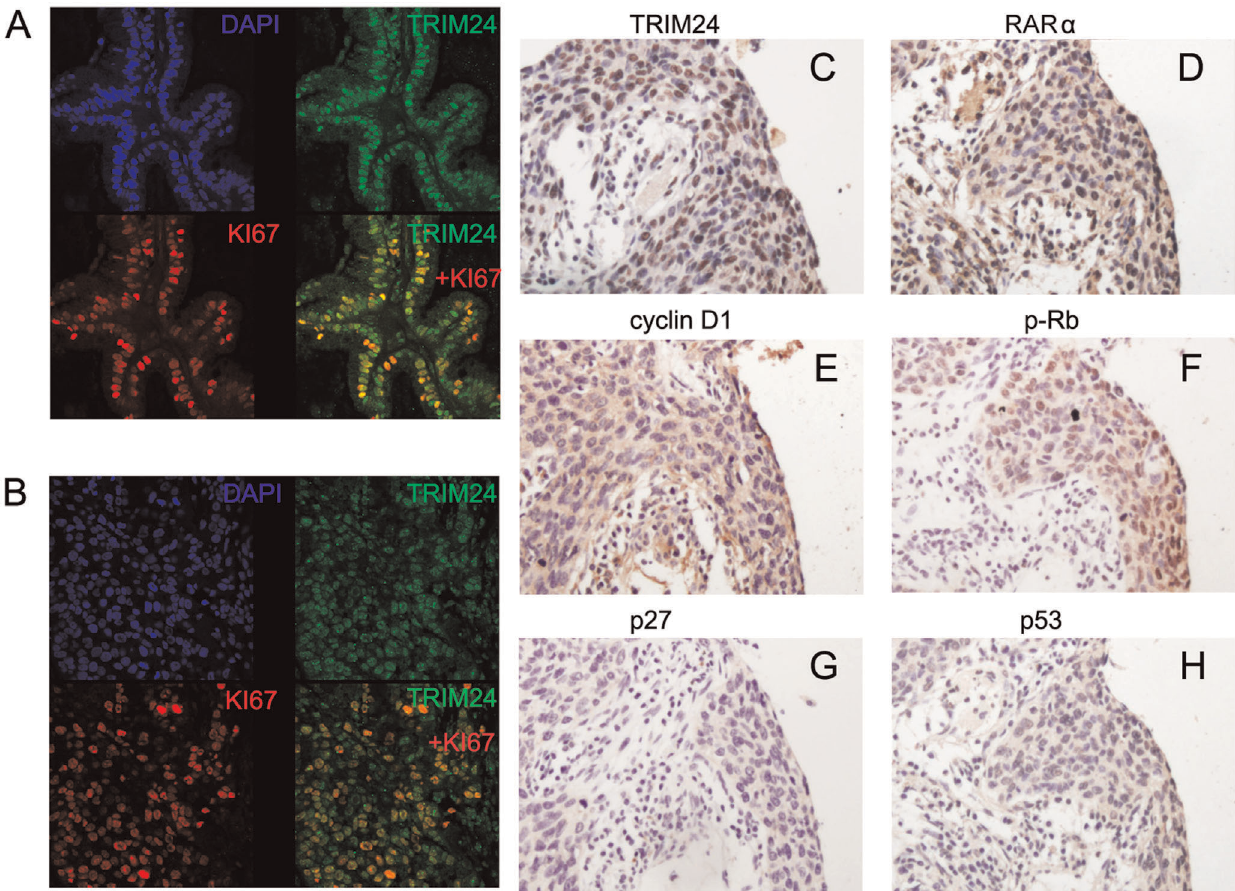
Figure 2. TRIM24 expression in NSCLC tissues was associated positively with the expression of Ki-67, cyclinD1 and p-Rb. Immunofluorescence staining showed co-localization of TRIM24 and Ki-67 in adenocarcinoma (A) and squamous cell carcinoma (B). Immunohistochemical staining for TRIM24 (C) and RAR a (D), cyclinD1 (E), p-Rb (F), p27 (G) and p53 (H) staining in a case of NSCLC.